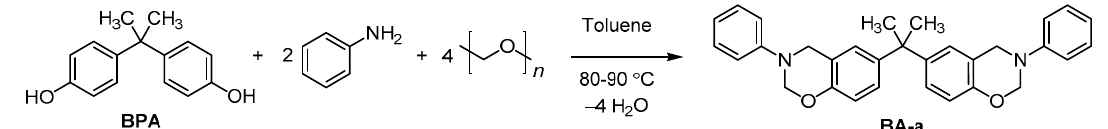
Scheme 1. Synthesis of benzoxazine monomer (BA-a) by the reaction of bisphenol A, aniline and